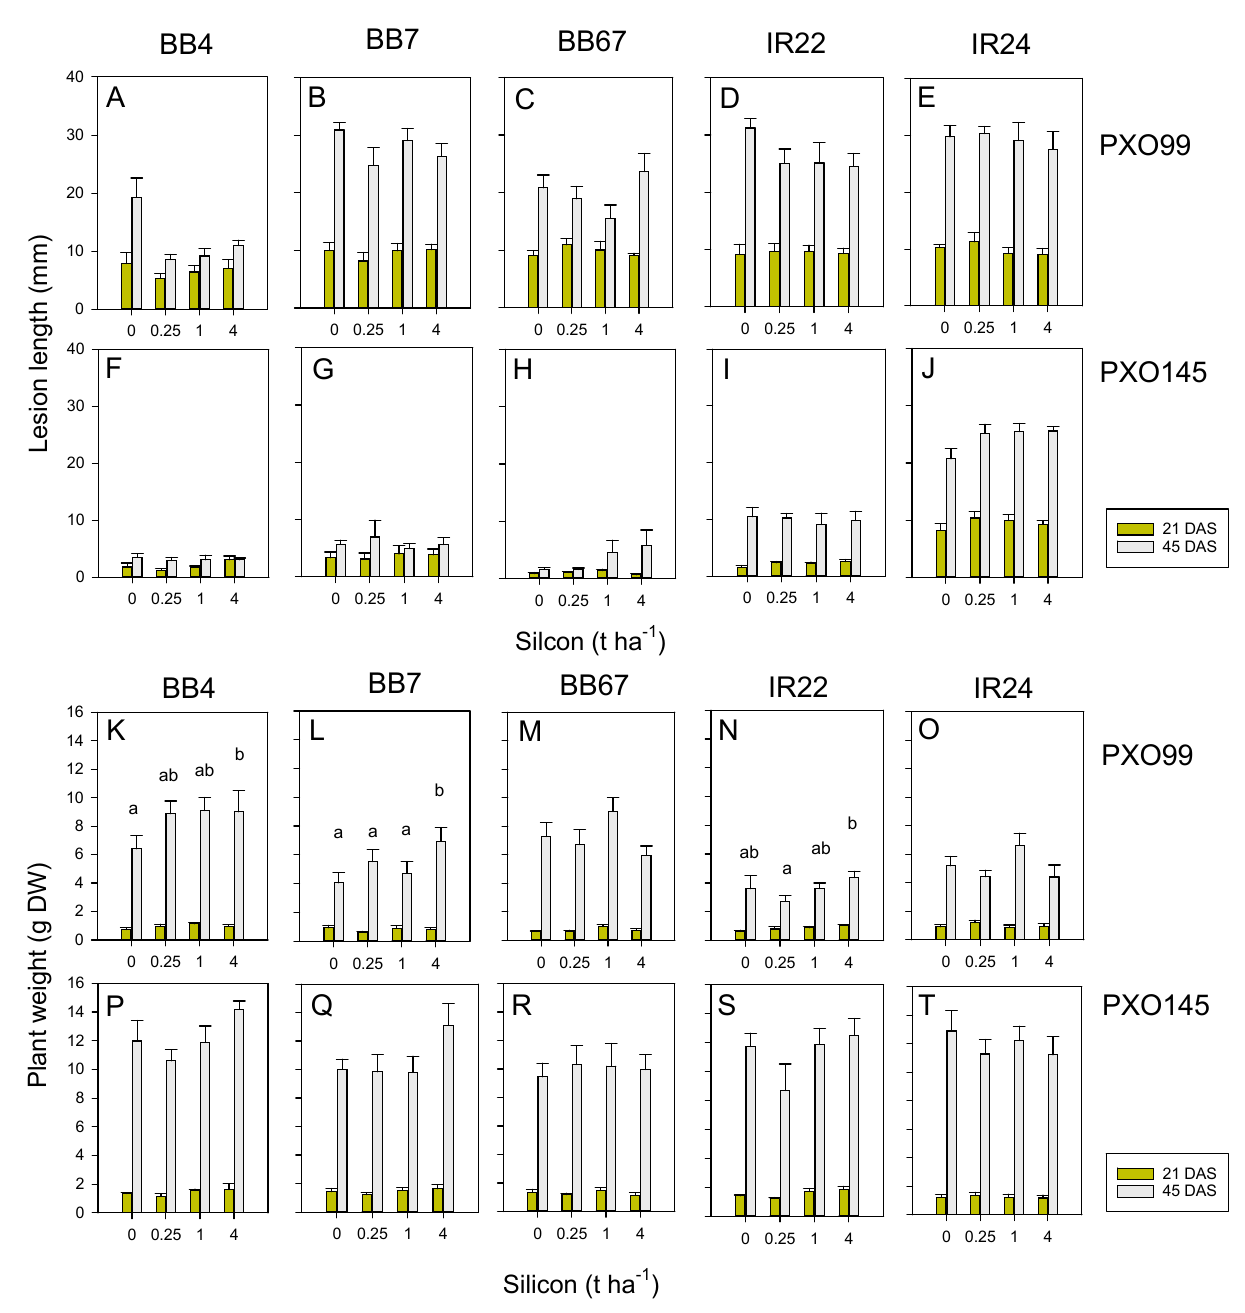
Figure 6. Effects of soil silicon on damage to rice from two strains of bacterial leaf blight (Xoo) to five rice varieties. Plants were challenged with ( A – E , K – O ) the highly virulent PXO99 strain and ( F – J , P – T ) the moderately virulent strain PX0145, under greenhouse conditions. The near-isogenic lines BB4 ( A , F , K , P ) and BB7 ( B , G , L , Q ) have monogenic resistance against PXO145 through the Xa4 and Xa7 R-genes, respectively. The pyramided line BB67 ( C , H , M , R ) contains both R-genes for resistance to PXO145. The varieties IR22 ( D , I , N , S ) and IR24 ( E , J , O , T ) were used as susceptible controls; however, IR22 was found to be also resistant to PXO145 ( I ). The effects of Xoo were evaluated as lesion length ( A – J ) and rice plant weight ( K – T ) with evaluations conducted at 32 (21 DAS + 11 DAI; yellow bars) and 59 (45 DAS + 14 DAI; grey bars) days. Soil was amended with 0, 0.25, 1 and 4 t ha − 1 equivalents of silicon. Lowercase letters in ( K – T ) indicate homogenous silicon groups based on partitioned analyses of varieties. Standard errors are indicated (sample size = 6). See also Table S10, and see Table S11 for results of repeated-measure GLMs.